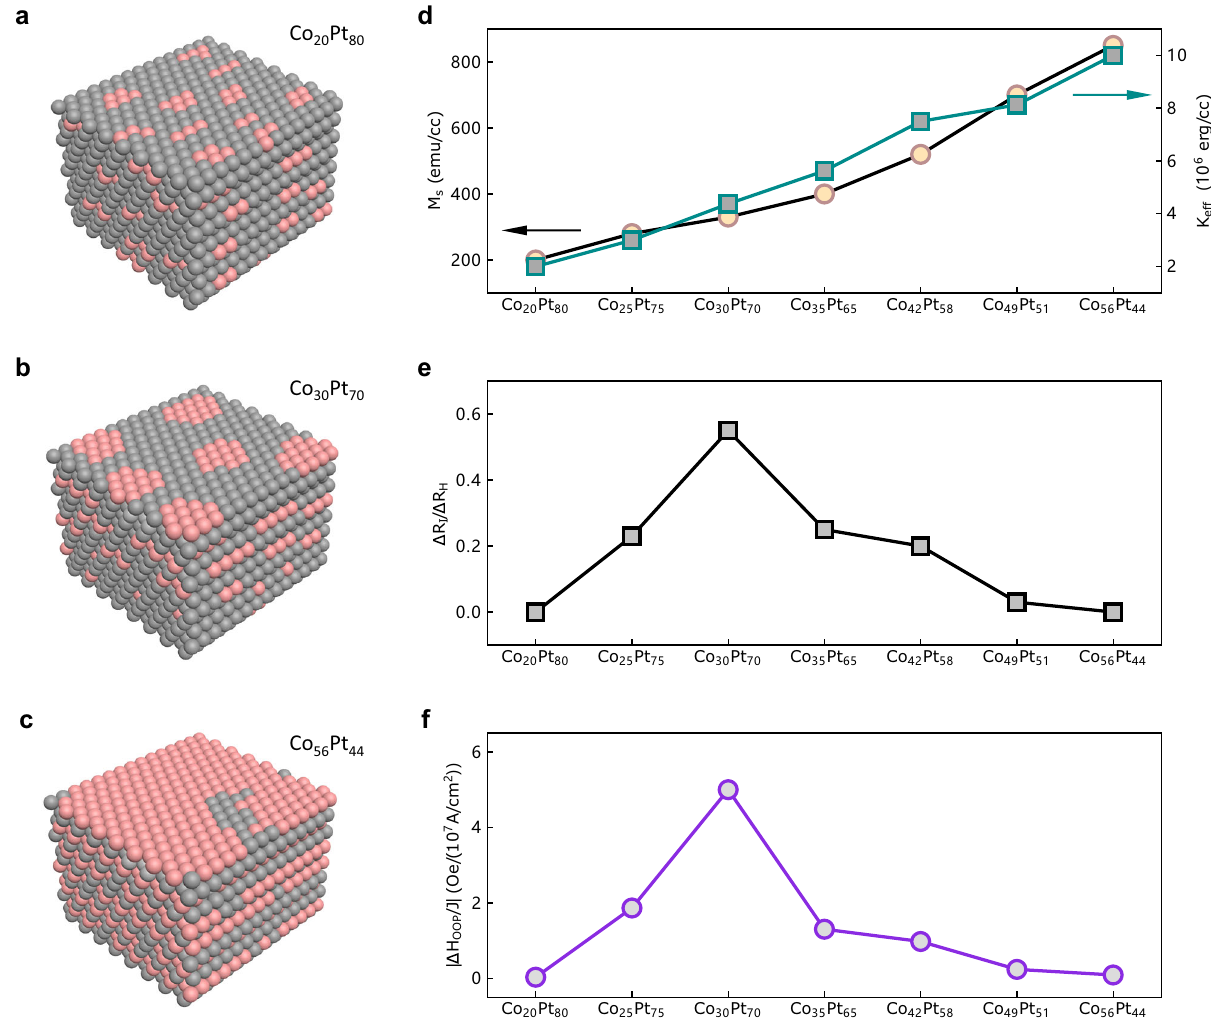
Fig. 4 Composition dependence of the OOP effective fi elds and switching behavior in Co x Pt 100- x single layers on SrTiO 3 (111) substrates. a – c Tentative structures of Co 20 Pt 80 , Co 30 Pt 70 , and Co 56 Pt 44 , which correspond to the lowest, optimal and highest Co compositions in our experiments, respectively. A large disordered background was omitted in these structures for easier analysis. Since the Co platelets are mainly distributed near the substrate, the top side of the structure in ( b ) is adjacent to the substrate. d Composition dependence of M s and K eff in Co x Pt 100-x single layers. e Composition dependence of Δ R Δ R I / H in Co x Pt 100-x single layers. f Composition dependence of